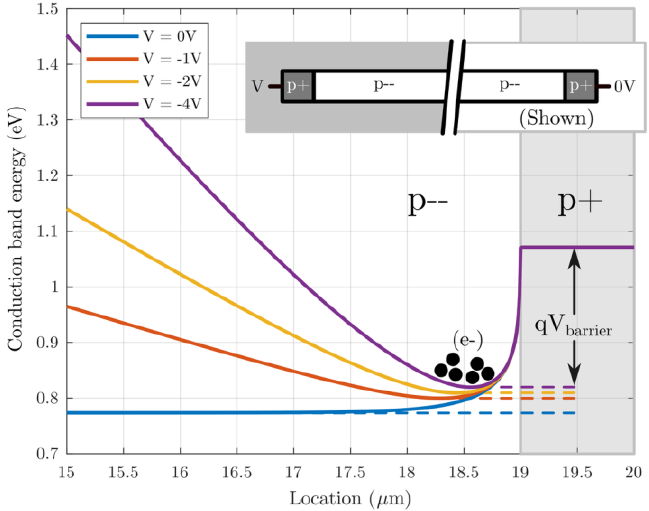
Figure 4. Simulated timing response of the device when illuminated with a sharp light pulse (10 ps) of 850 nm for a few different ring voltages.